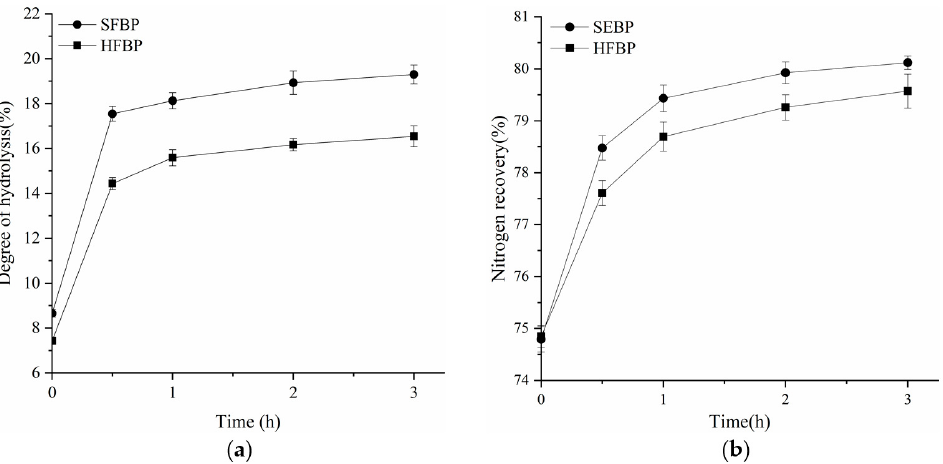
Figure 1. Degree of hydrolysis ( a ) and nitrogen recovery ( b ) of SFBP and HFBP by Flavourzyme. SFBP: fish bone protein prepared through steam explosion-assisted extraction; HFBP: fish bone protein prepared through hot-pressure extraction.